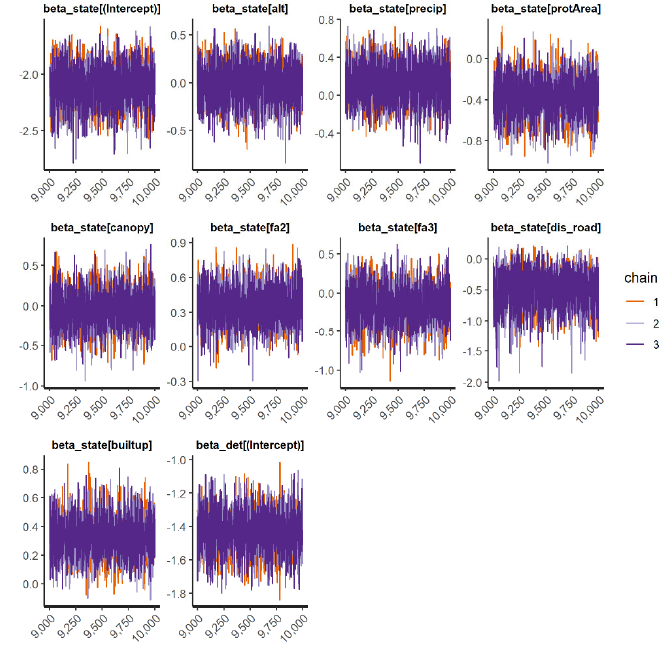
Figure A15. Traceplots from the best occupancy model of domestic dog ( Canis lupus familiaris ) in Puerto Rico: ( ψ (intercept + elevation + precipitation + protected area + canopy cover + fa2 + fa3 + distance of road + built up); 𝜌 (intercept + elevation)). Note: alt = elevation; precip = mean annual precipitation; protArea = proportion of protected area; canopy = proportion of canopy cover; fa2 = proportion of forest cover aged between 32 and 54 years; fa3 = proportion of forest cover aged 55 years and older; dis_road = minimum distance from road; builtup = built ‐ up proportion.